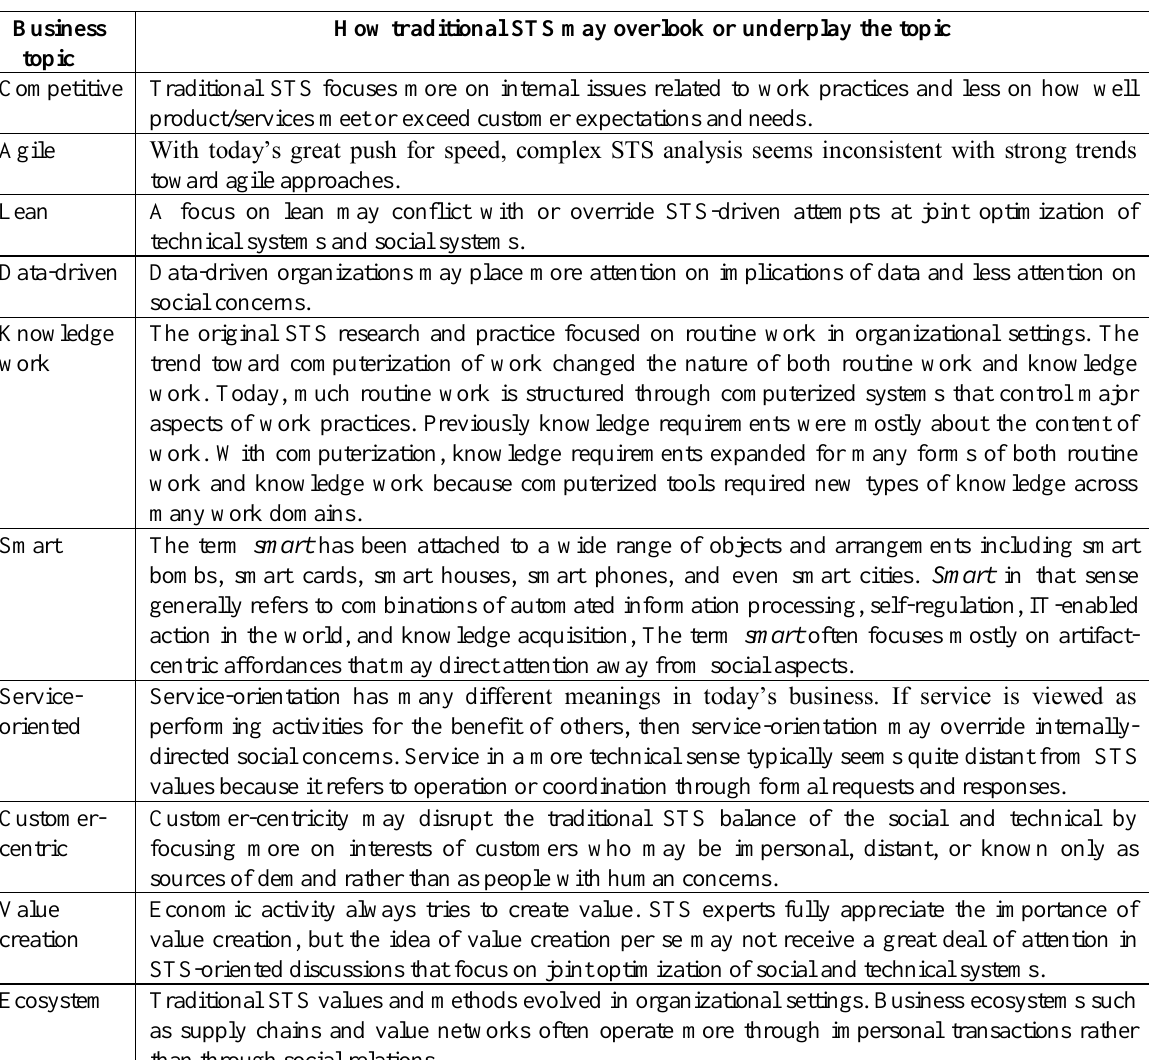
Table 2. Business topics and issues that STS should be able to address